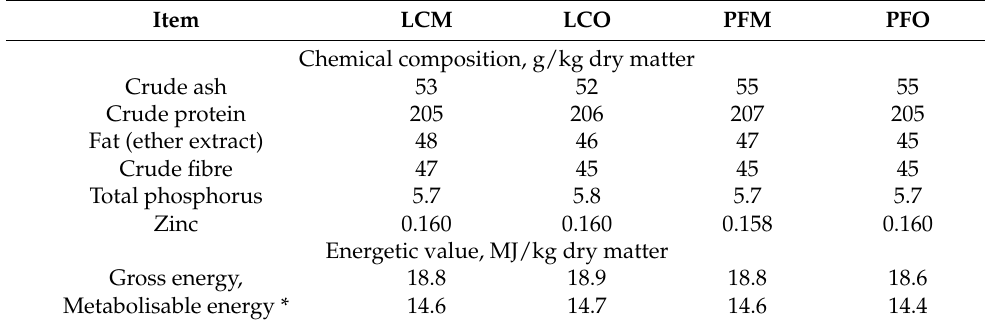
Table 1. Composition and energetic value of the diets.